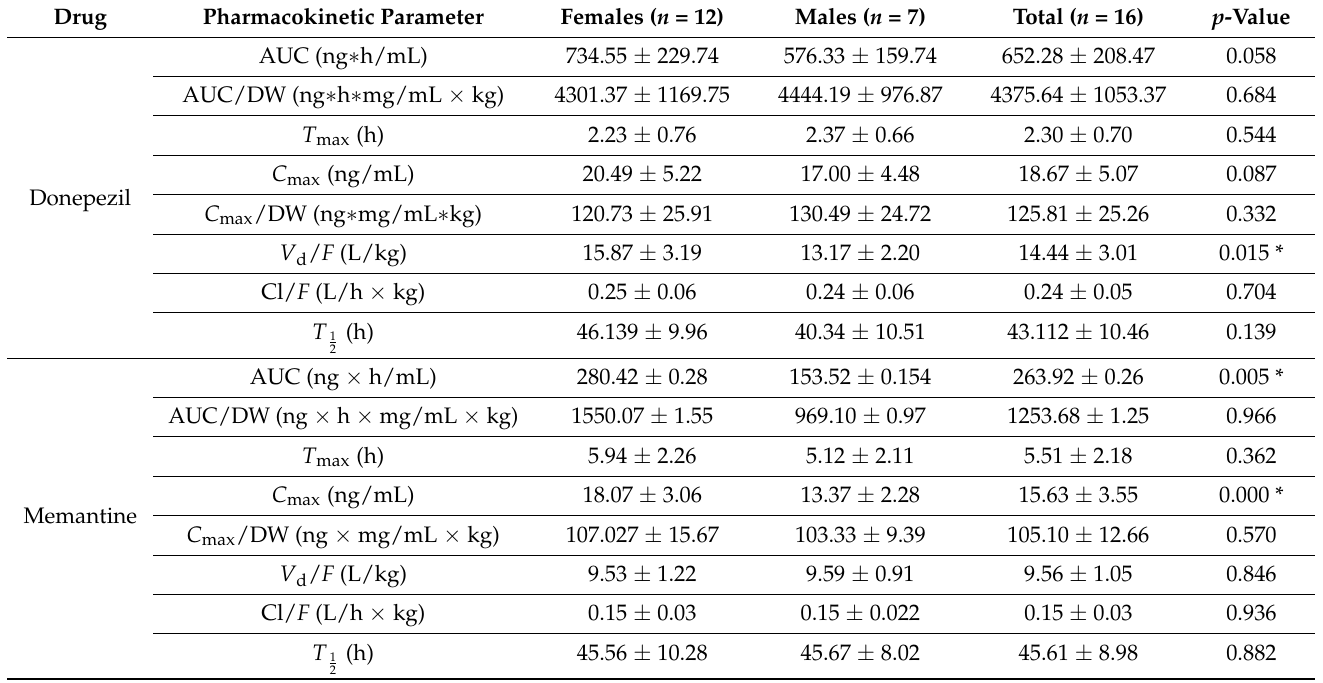
Table 2. Pharmacokinetic parameters of memantine and donepezil regarding